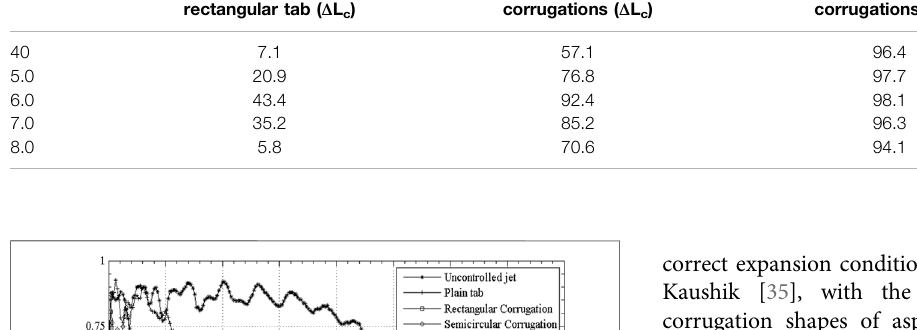
Tab with rectangular corrugations ( Δ L c )